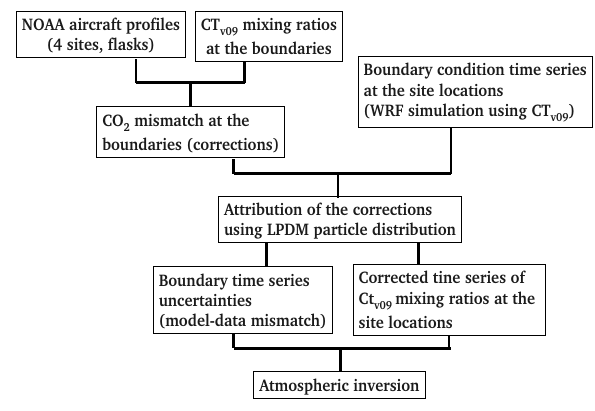
Fig. 2. Schematic framework of the boundary conditions including the mixing ratio pre-processing and the estimation of the uncertainties